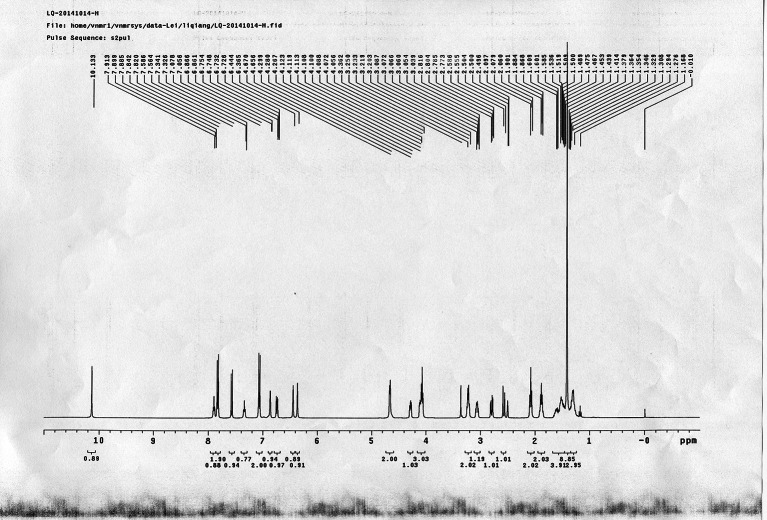
1H NMR spectra of compound 25.